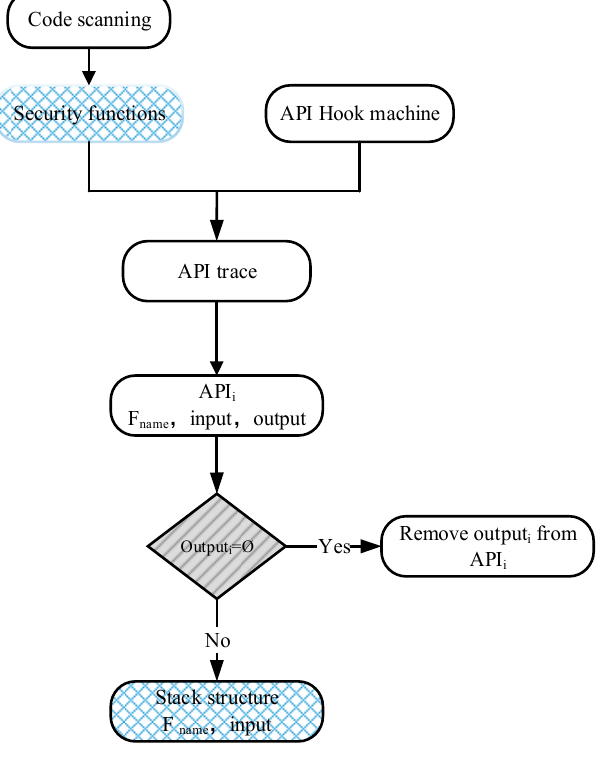
Figure 15. API trace parse module.